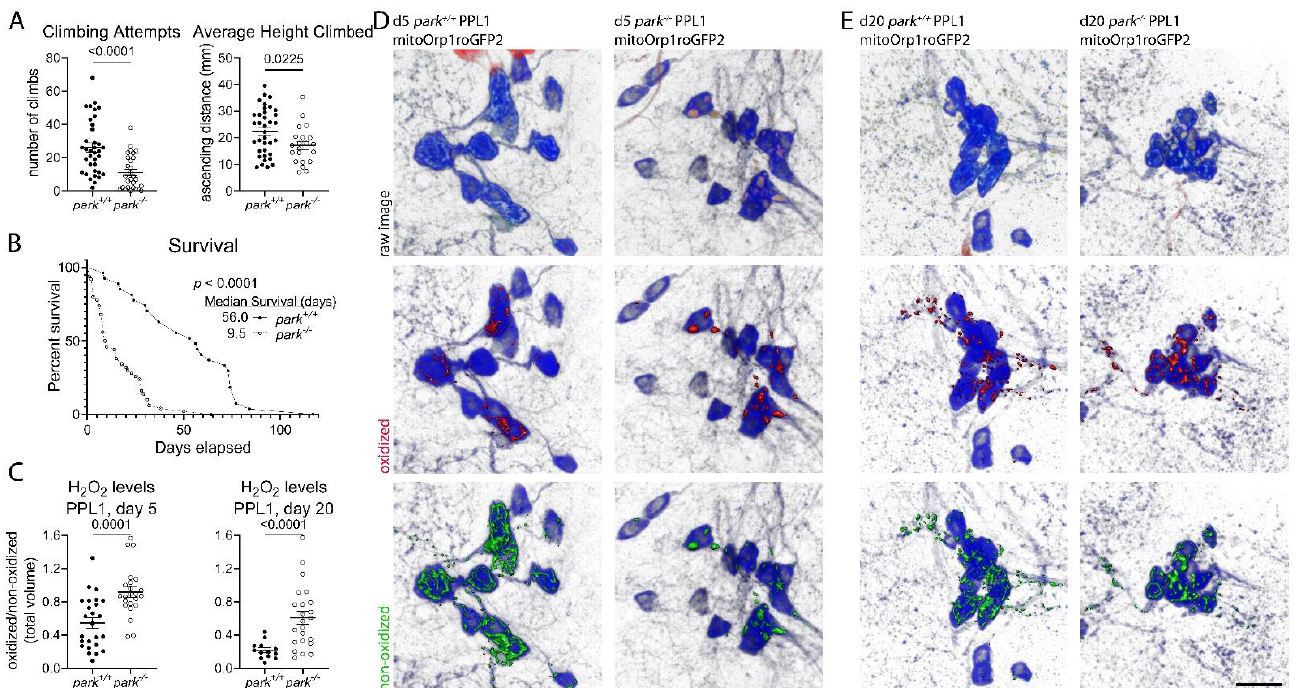
Figure 1. Parkin-null Drosophila have decreased climbing behavior and increased mortality and PPL1 mitochondrial hydrogen peroxide levels. ( A ) Individual fly climbing attempts and average height climbed were recorded for 20 min in the MB5 Multibeam Drosophila Activity Monitoring System. Each data point represents data from one control ( park +/+ ) or parkin-null ( park −/− ) fly ( n ≥ 21). A Welch’s t test and an unpaired t test were performed to determine effect of genotype on attempts, and height climbed, respectively. ( B ) For the survival study, flies were monitored every 2 – 3 days, and percent surviving were reported until all flies expired ( n ≥ 27) . Gehan – Breslow – Wilcoxon test was performed to determine the effect of genotype. ( C ) Brains were dissected from park +/+ and park −/− flies expressing mito-roGFP2-Orp1 on days 5 and 20 post-eclosion, and ratios of total volumes of oxidized to non-oxidized fluorophore emissions were calculated for one PPL1 region per brain. Each data point represents the ratio from one PPL1 region ( n ≥ 13). An unpaired t test and a Welch’s t test were performed to determine the effect of genotype on hydrogen peroxide levels on day 5 and 20, respectively. Error bars represent standard error of the mean. p values are reported for each comparison in ( A – C ). Representative panels of PPL1 images on ( D ) day 5 and ( E ) day 20. Raw images are shown in the top row, where blue indicates tyrosine hydroxylase antibody labeling, and red and green indicate oxidized and non-oxidized roGFP2, respectively. Selected volume “isosurfaces” of oxidized (red, middle row) and non-oxidized (green, bottom row) mito-roGFP2-Orp1 above threshold are also shown. Scale bar, 10 µm.